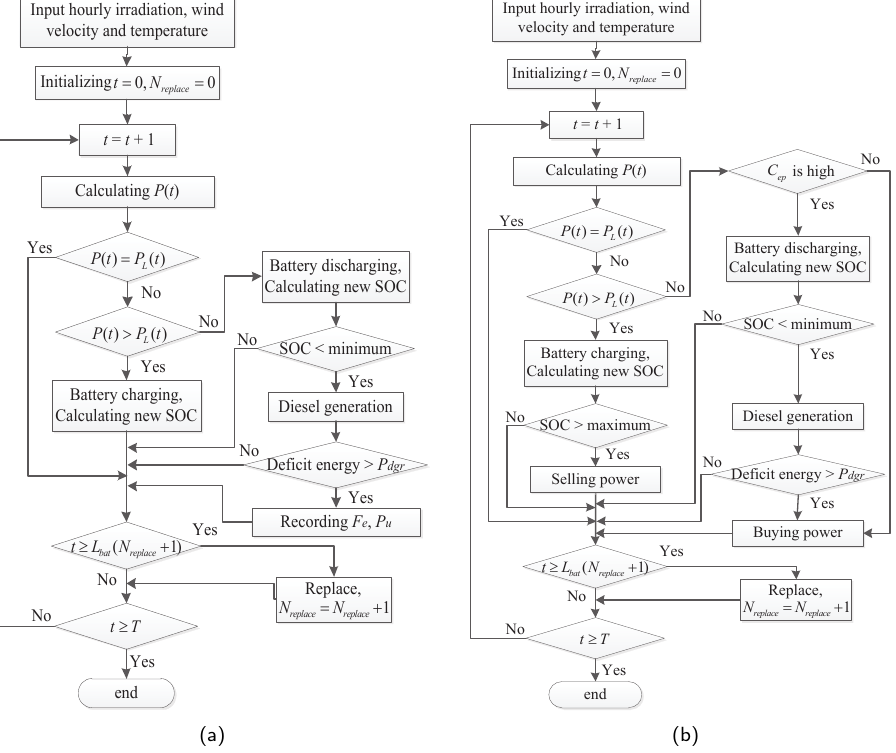
Figure 3. Flowchart of system simulation. ( a ) the isolated-island mode; and ( b ) the grid-connected mode. SOC: state of